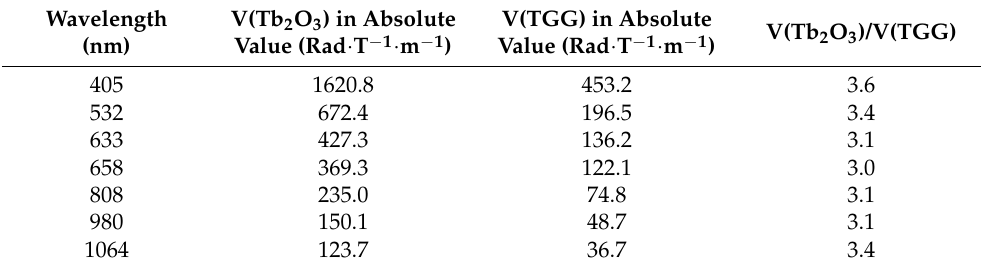
Table 1. Verdet constants of Tb 2 O 3 ceramics at different wavelengths and the Verdet constants of TGG crystal in Ref. [58] for comparative